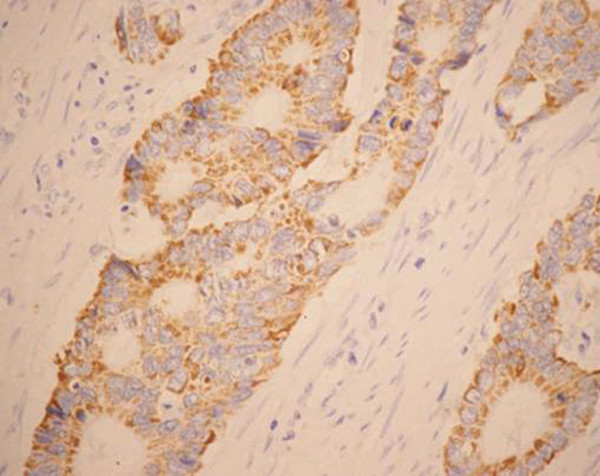
Staining of VEGF in colorectal cancer cells (EnVision, ×400). Typical cytoplasmic immunoreactivity of VEGF.